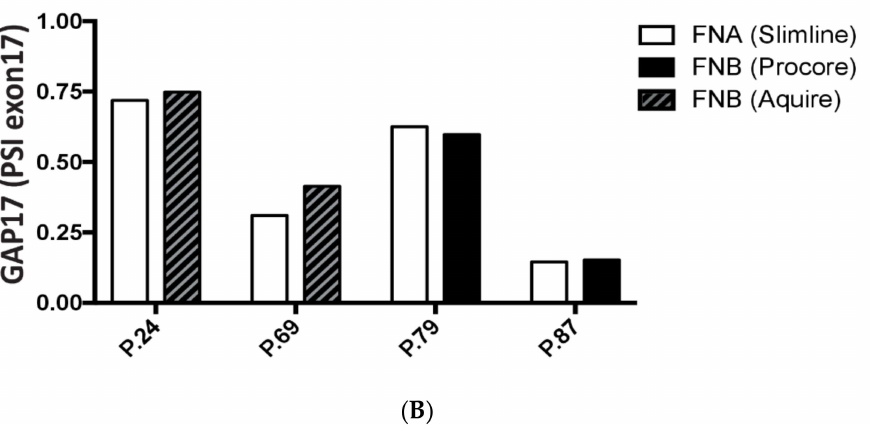
Figure 6. Representative examples of the evaluation of polyC-rich exon inclusion in the GTPase GAP17 (ARHGAP17 gene) in samples obtained from EUS-TA; (panel A ): RT-PCR with upper and lower bands representing respectively polyC inclusion and respectively; (panel B ): percentage of Spliced-In Index (PSI / ψ ) based on PCR band